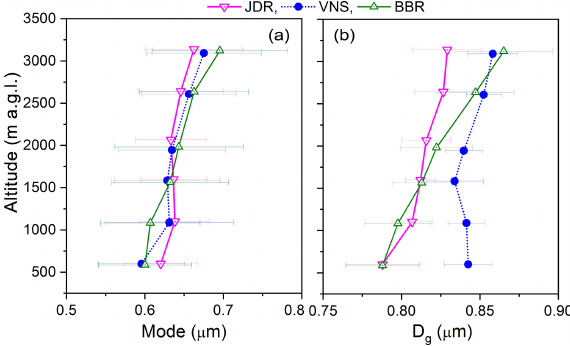
Figure 5. Vertical profiles of (a) mode and (b) geometric mean diameters ( D g ) of aerosol number size distributions at different heights above the ground level, indicating the change in the pat- tern of distribution with altitude and from the western to the eastern part of the